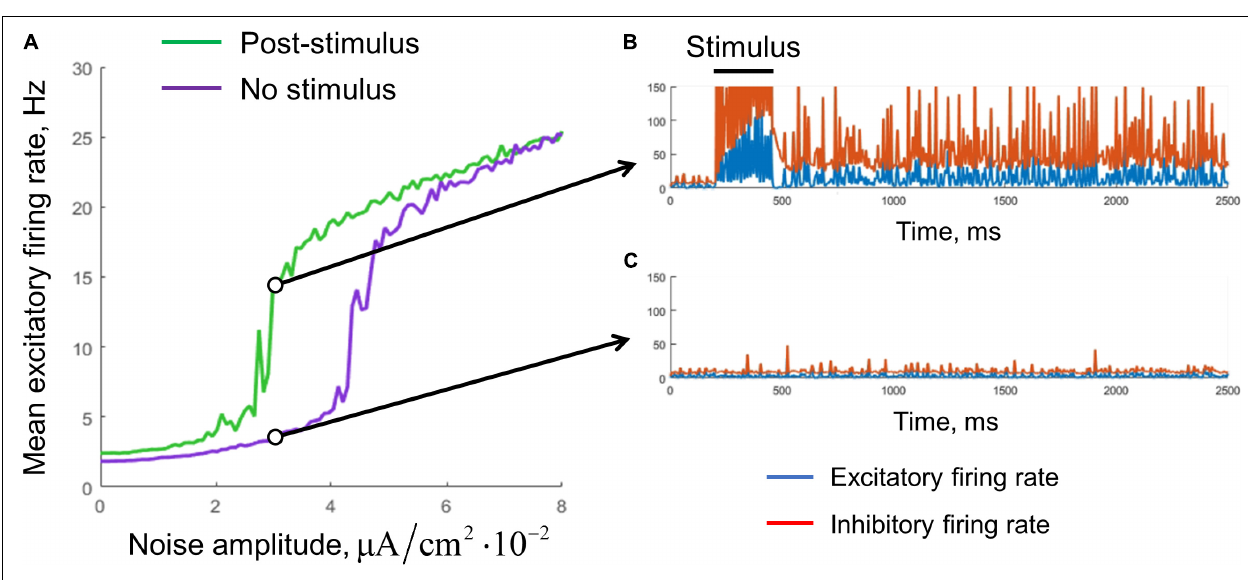
FIGURE 4 | Stabilization of the single-circuit metastable activity by a noisy input. (A) Mean excitatory firing rate, averaged over the interval 1–10 s. Green, the result for post-stimulus activity; purple, for background activity (without stimulus presentation). The stimulus presentation interval was 200–450 ms. The noise was delivered during the whole simulation time. Examples of the post-stimulus and the background activity traces ( A ex , NOISE = 3 × 10 − 2 µ A / cm 2 ) are presented in (B,C) , respectively. Blue curves, excitatory firing rate; red curves, inhibitory firing